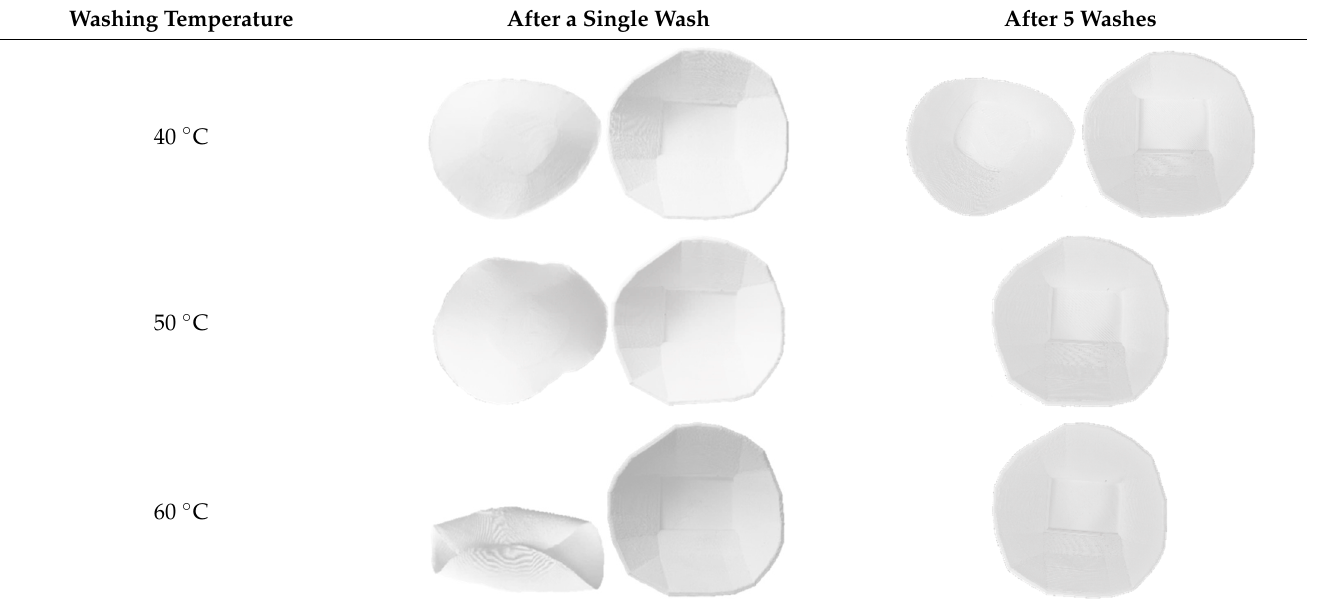
Table 4. Results of shape stability testing at different washing temperatures.